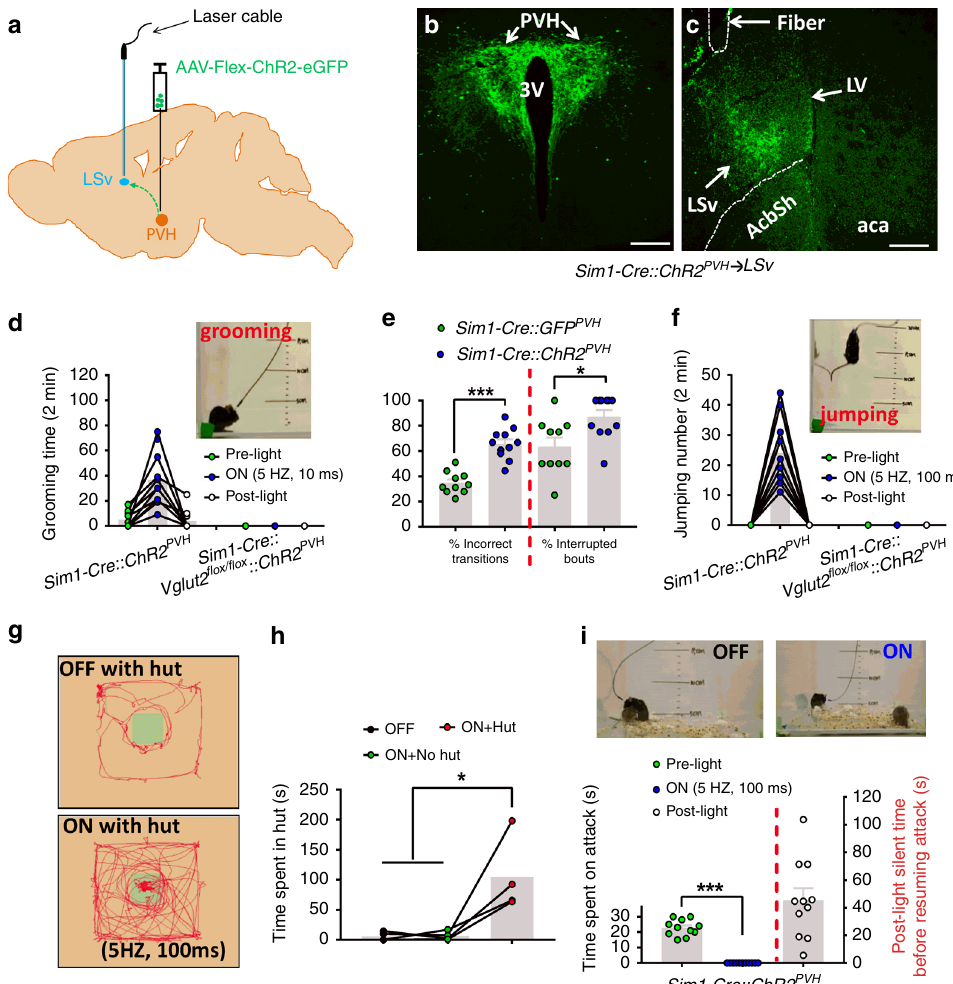
Fig. 2 Activation of PVH → LSv projections drives behaviors associated with negative emotional states. a – c Sim1-Cre and Sim1-Cre::Vglut2 fl ox/ fl ox mice (males) with AAV-Flex-ChR2-eGFP delivery to the PVH and fi ber optic implantation targeting LSv were used for behavioral assays a . Representative pictures showing AAV vector expression in the PVH b , arrows, and GFP-expressing fi bers and optic fi ber trace in LSv c , arrows. d – f These mice were used for a 2 min testing period. In Sim1-Cre mice, self-grooming behaviors were induced by short-pulse phototimulation (10 ms/5 Hz, 5 mW/mm 2 ) ( d , online Movie 1) and frantic jumping behaviors were induced by long pulse photostimulation (100 ms/5 Hz, 5 mW/mm 2 ) ( f , online Movie 2), neither of which were observed in Sim1-Cre::Vglut2 fl ox/ fl ox mice d and f . e Quantitation of self-grooming behaviors shows increased bout and transition ( n = 10 – 11; comparison between % incorrect transitions, p < 0.001; comparison between % interrupted bouts, p = 0.012). g , h Mice were used for a shelter box test in which mice movements were tracked in an open arena with box (shaded areas in g ) placed in the center. More time spent in the box represents an increase in fear. Photostimulation of PVH → LSv terminals increased time spent in the box, or in the same area the box occupied, compared with either photostimalation without the box or without photostimulation ( h , n = 4, p = 0.0108 or p = 0.0113). i Representative snapshot pictures of attacking intruders by resident mice with no (OFF) or the long pulse photostimulation (ON) of PVH → LSv fi bers (top pictures), and time spent in attack during the 30 s periods of pre-light and light-on (ON, also online Movie 3), and 2 mins post light ( i , bottom; n = 11, p < 0001). * p < 0.05, *** p < 0.001, paired student ’ s t tests for e and I , One-way AVONA tests for h . Scale bar = 100 µ M . PVH: paraventricular hypothalamus; LSv: ventral part of lateral septum; 3 V: the third ventricle; aca: anterior commissure area; AcbSh: accumbens shell suggesting a state of fear elicited by selectively photostimulating Sim1-Cre::Vglut2 fl ox/ fl ox mice lacking glutamate release from Sim1- the PVH → LSv projection. To test whether photostimulation of Cre neurons 36 (Fig. 2e, f), suggesting an absolute requirement of PVH → LSv terminals reduces aggression, an emotional state glutamate release for the observed behaviors. Given the known consistent with increased fear, we examined aggression in resident role of the LS in fear 34 , we next questioned if the escape jumping mice during resident-intruder assays. For this, we scored resident behavior represents a state of fear. Toward this, we performed a mice that were engaged in continuous attacks toward the intruder modi fi ed shelter hut test, which was previously used to test a fear by chasing, mounting, and fi ghting (Fig. 2i), all of which were response 39 . We placed the shelter hut in center instead of corner to assess the ability of animals to actively search for safety for completely blocked upon photostimulation, and immediately hiding. Unilateral photostimulation of PVH → LSv terminals sig- resumed post stimulation (Fig. 2i, Supplementary Movie 3). These ni fi cantly increased time spent inside a shelter hut placed in the results collectively demonstrate that activation of the PVH → LSv center of the recording arena compared with without photo- projection drives rapid changes in emotional states ranging from stimulation, or with photostimulation but without hut (Fig. 2g, h), stress to fear, which requires glutamate release. NATURE COMMUNICATIONS| (2019) 10:3446